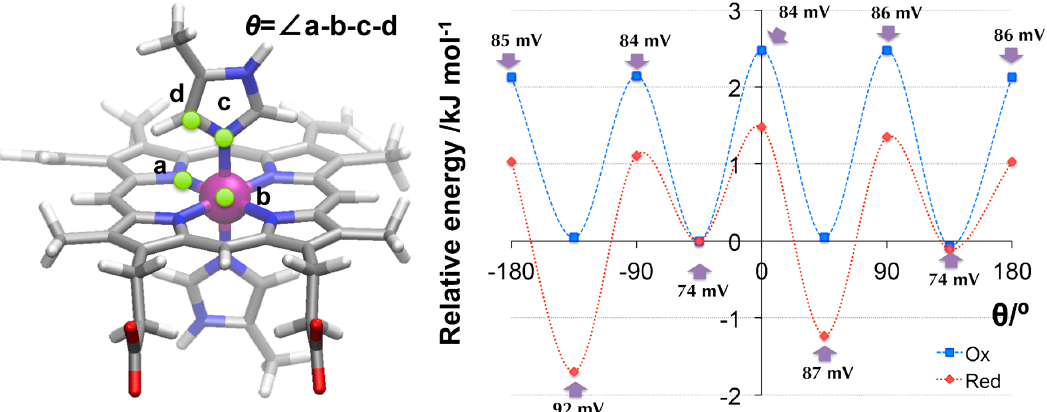
Figure 2. The potential energy surface of the oxidized/reduced state in heme b . The zero-point is set